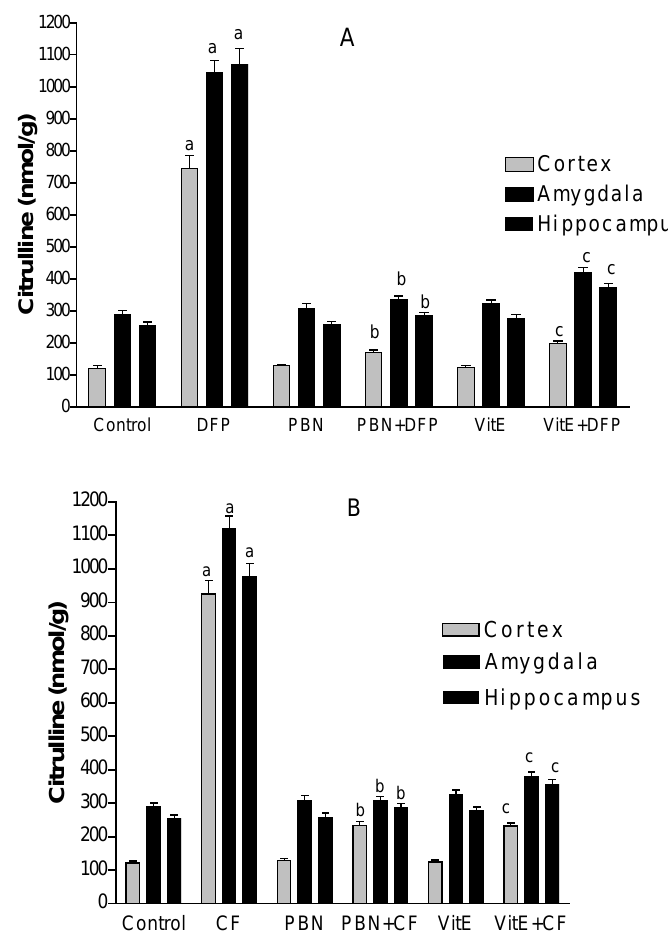
FIGURE 7. Protection for (A) DFP- or (B) CF-induced changes in citrulline levels in rat brain regions by antioxidant treatment with PBN or Vit E. Values of citrulline are presented as mean ± SEM (n = 4–6). a Significant difference between values from control rats and DFP- or CF-treated rats ( p < 0.05), b Significant difference between values from DFP- or CF-treated rats and PBN+DFP– or PBN+CF–treated rats ( p < 0.05), c Significant difference between values from DFP- or CF-treated rats and VitE+DFP– or VitE+CF–treated rats ( p <